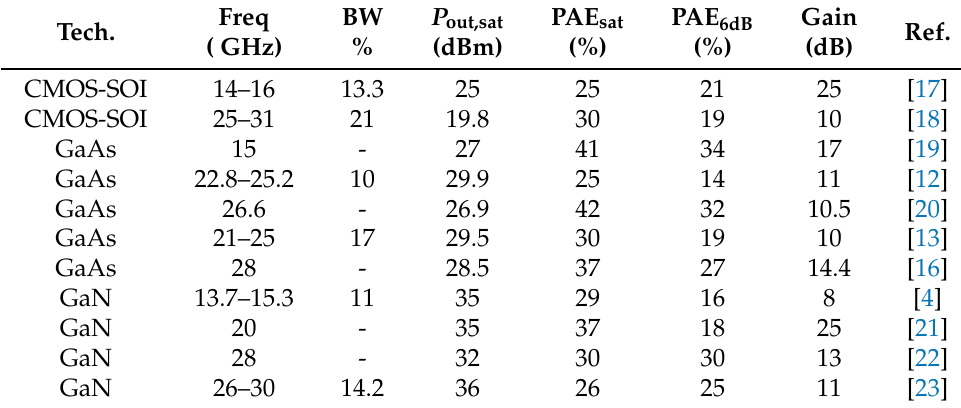
Table 1. Performance of K and Ka band state-of-the-art MMIC DPAs.